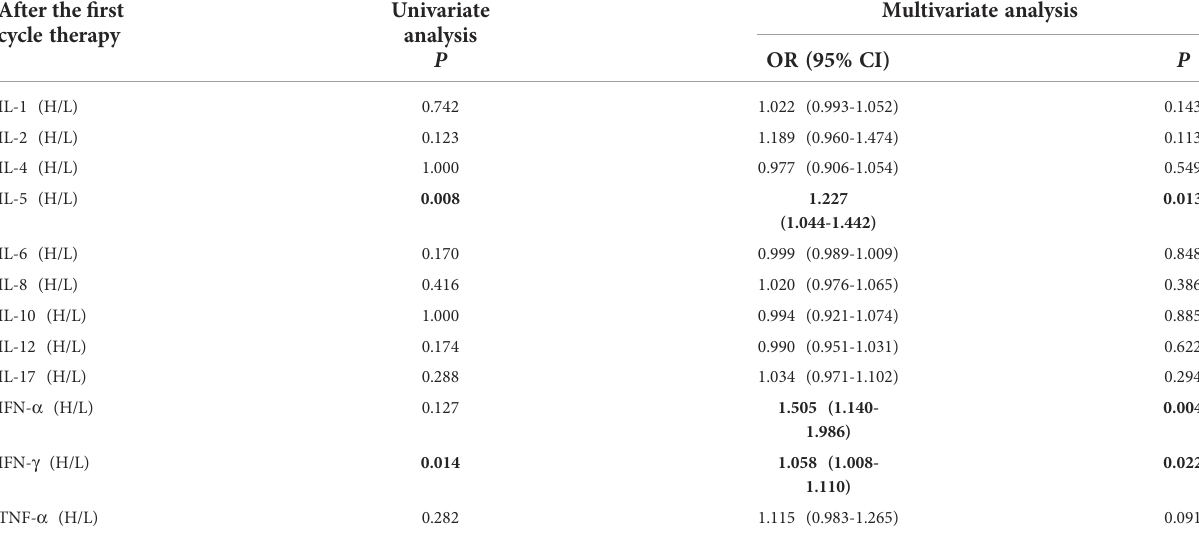
TABLE 3 Univariate and multivariate analysis results of cytokine levels after the fi rst cycle therapy between AE and NAE. After the fi rst cycle